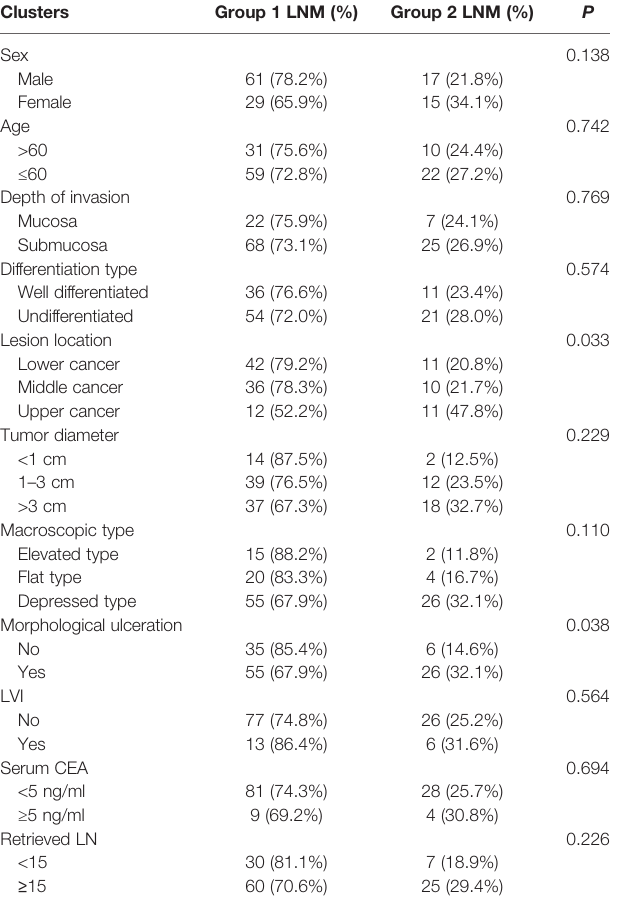
TABLE 3 | The relationship between clinicopathological characteristics and group 1 and 2 lymph node metastasis in EGC.